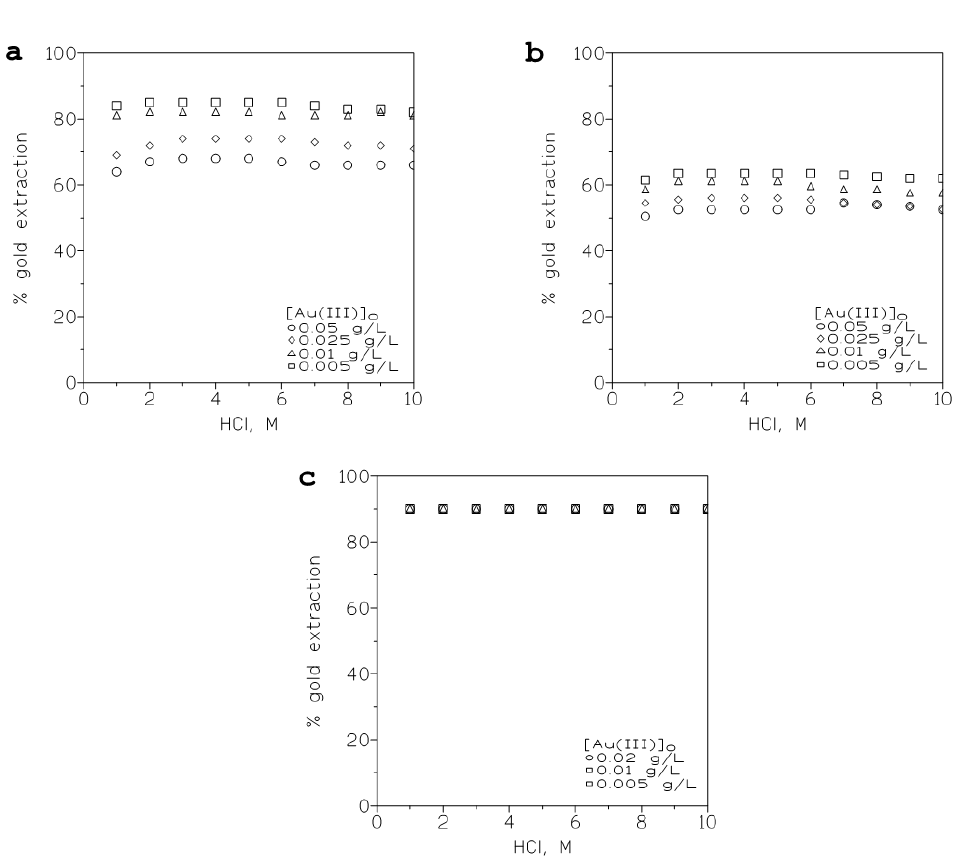
Figure 2. Variation of the percentage of gold(III) extraction versus HCl concentration in the aqueous phase at various initial metal concentrations. ( a ): 2.1·10 −2 M priNH 2 H + Cl − . ( b ): 2.3·10 −4 M secNHH + Cl − . ( c ): 1.1·10 −4 M terNH + Cl − . Equilibration time: 10 min. Temperature: 20 °C.